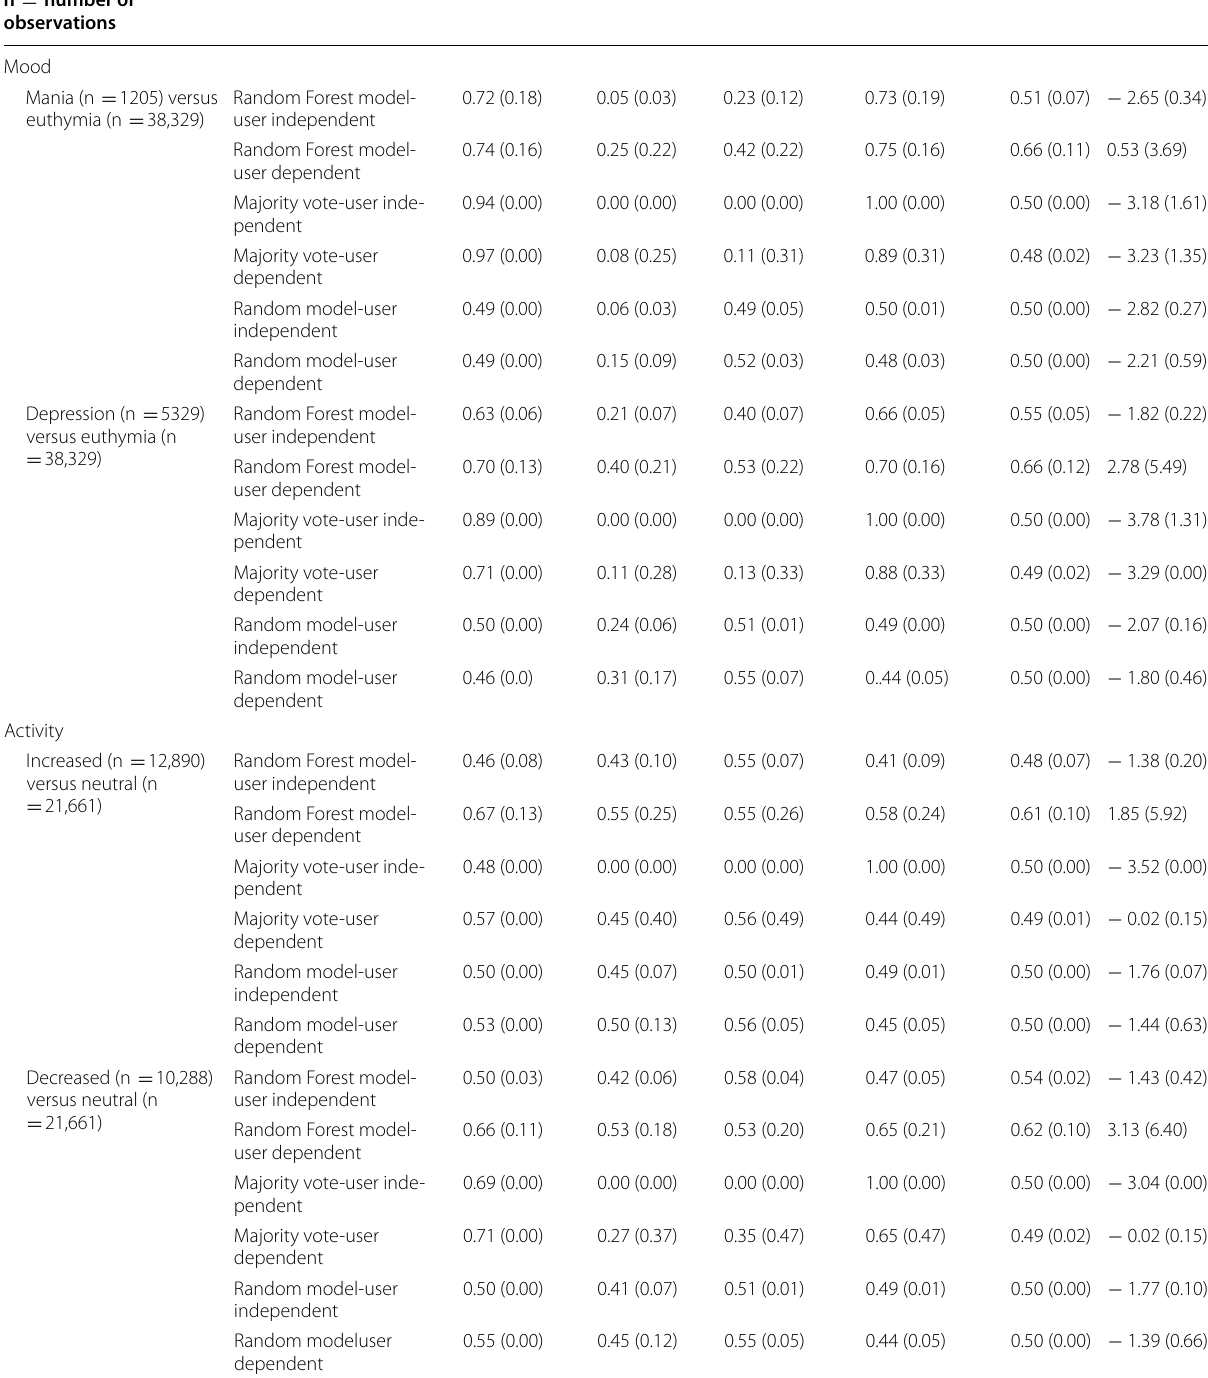
Table 3 Classification within patients with bipolar disorder (n mood, activity and sleep